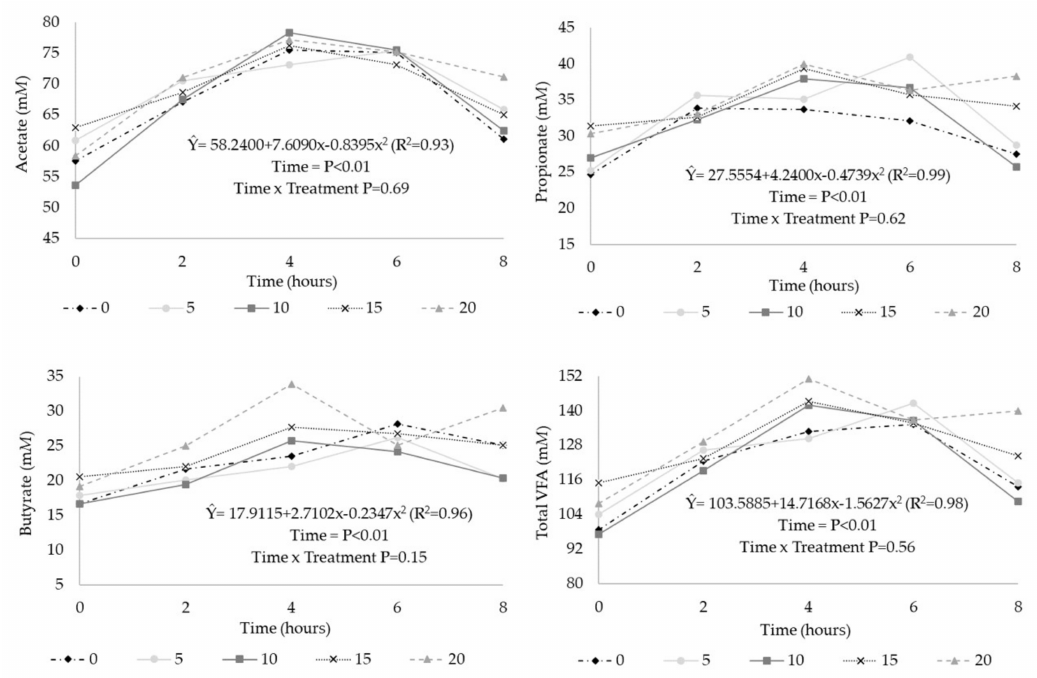
Figure 2. Concentration of ruminal volatile fatty acids in steers receiving diets with condensed tannins extract (CT) from Acacia mearnsii , as a function of time after feeding. 0 = no CT inclusion; 5 = 5 g of CT / kg of dry matter (DM); 10 = 10 g of CT / kg of DM; 15 = 15 g of CT / kg of DM; 20 = 20 g of CT / kg of